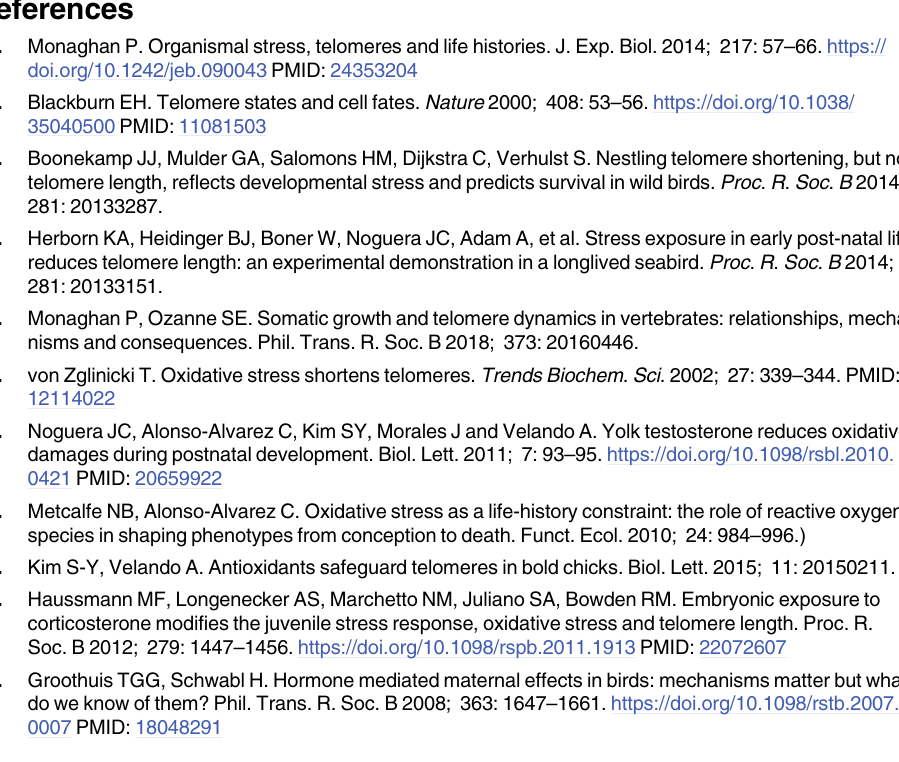
S3 Table. Linear mixed models of relative telomere length (RTL) in blood of yellow-legged gull hatchlings in relation to testosterone treatment, sex, and laying order. Total Antioxi- dant Capacity (TAC) and amount of pro-oxidant molecules (TOS) were singularly included in the models as a covariate. Clutch identity was included in the model as a random intercept effect. The non-significant effects of the two-way interactions between fixed factors were excluded from the final model. Significant effects are reported in